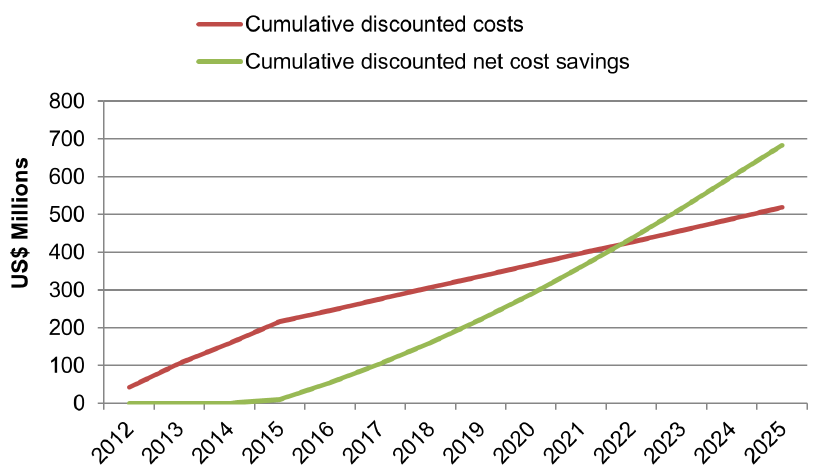
Figure 5. Cumulative net costs and cumulative net savings with VMMC scale-up (2010–2025).